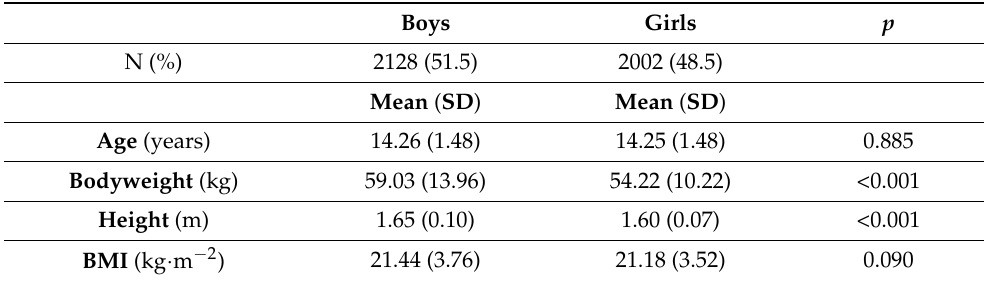
Table 1. Characteristic and anthropometry of participants segmented by age group and sex.